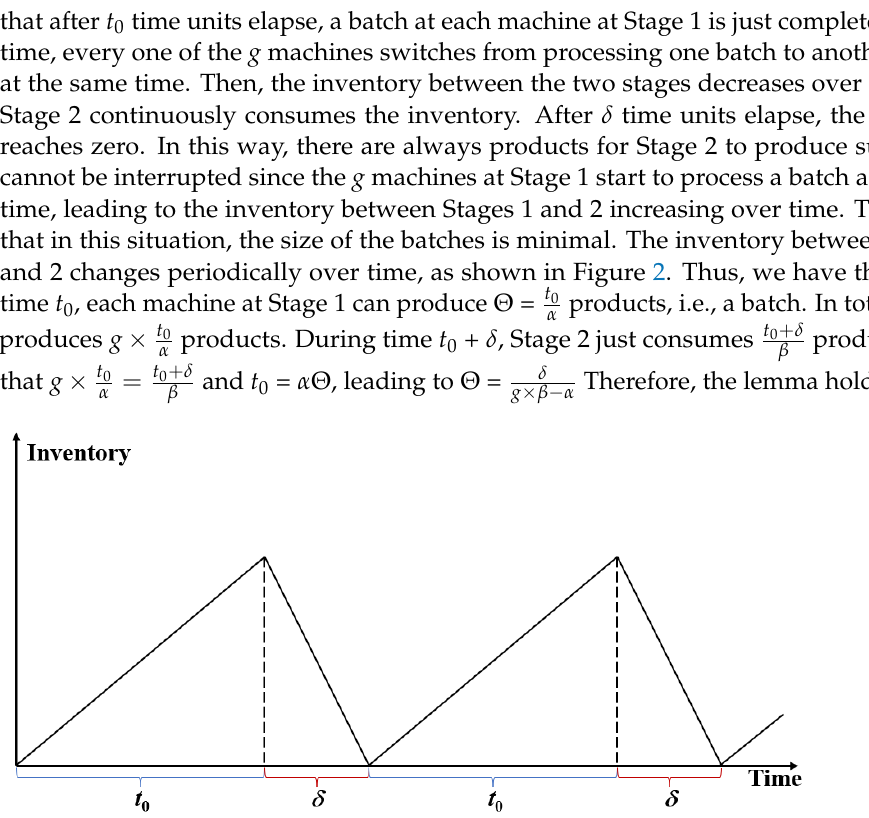
Figure 2. The changes of the inventory between Stages 1 and 2 over time.